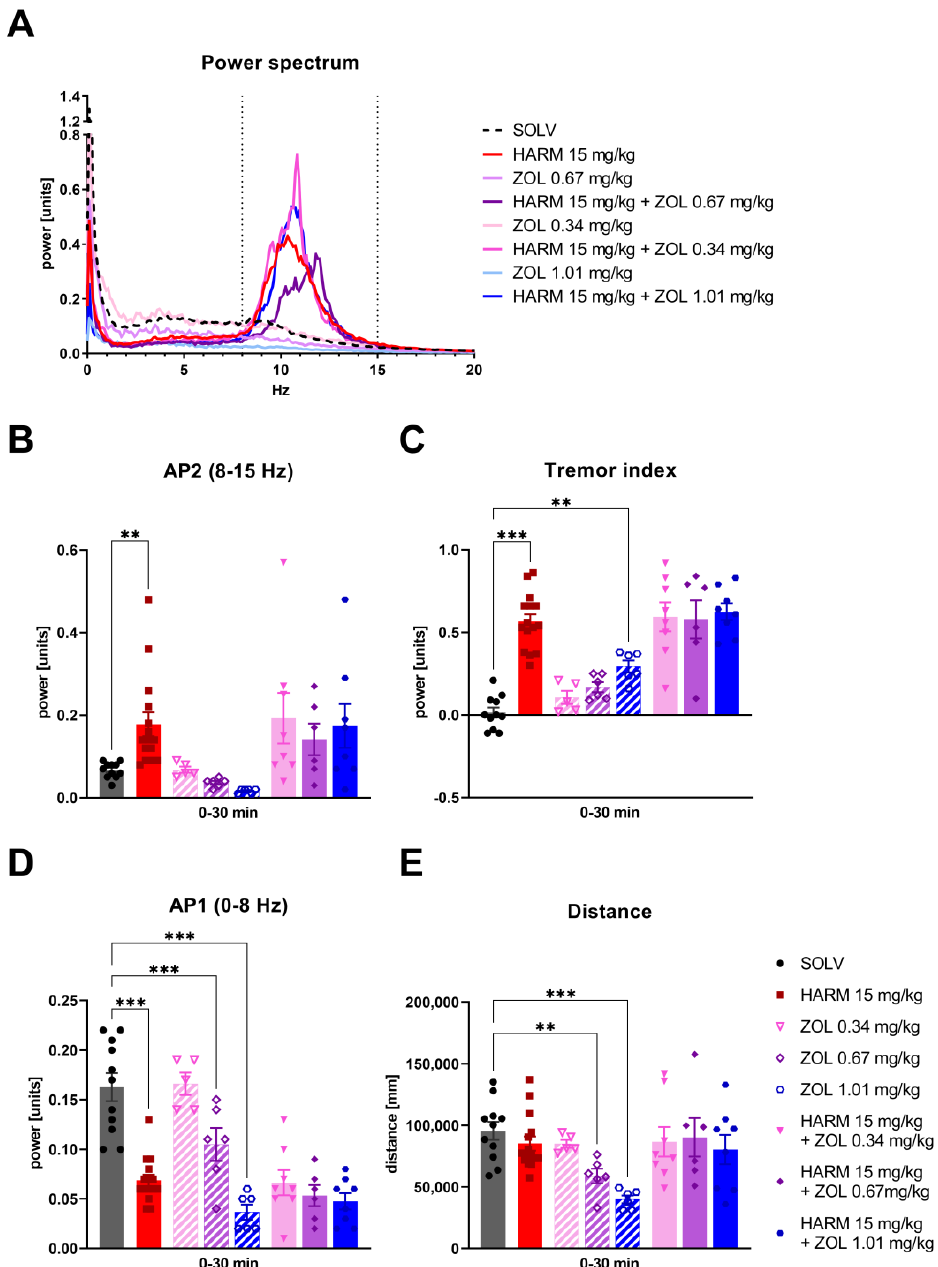
Figure 4. The effect of zolpidem (0.34, 0.67, 1.01 mg/kg) on harmaline-induced tremor: ( A ) power spectrum, ( B ) AP2, ( C ) tremor index, ( D ) AP1, and ( E ) locomotor activity (distance) of rats. The power spectrum within a range of 0–20 Hz, averaged over the whole measurement period (0–30 min) for all animals in each group is shown. Tremor parameters data are shown as the means ± SEM. AP1—power in the 0–8 Hz band, AP2—power in the 8–15 Hz band. The number of animals: